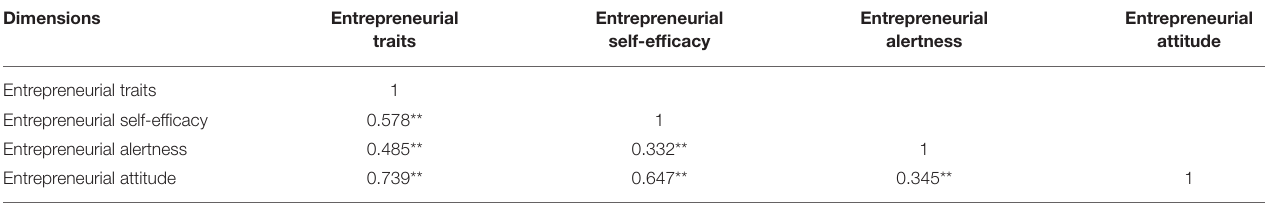
TABLE 2 | Correlation analysis of key variables.